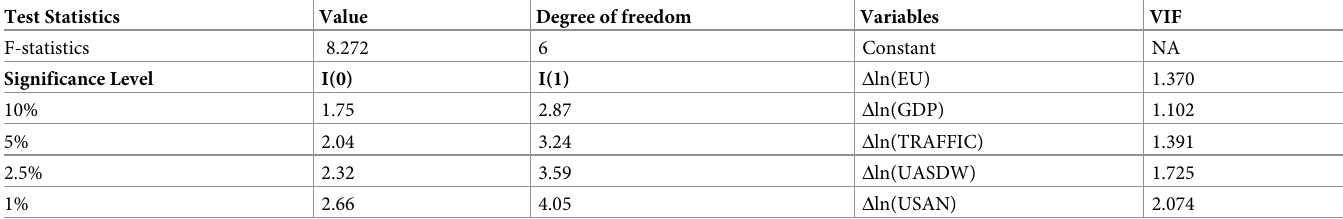
Table 5. ARDL bounds test